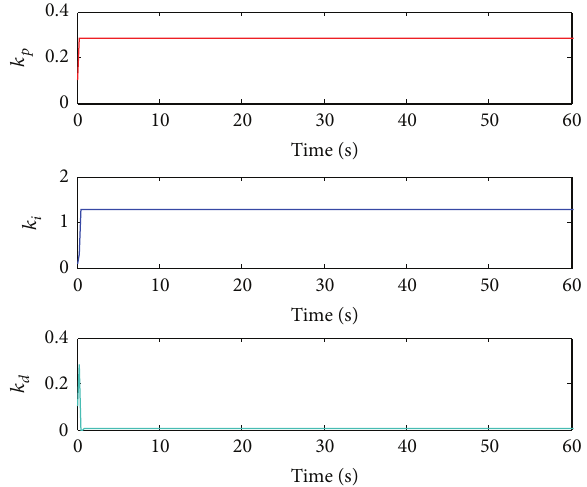
Figure 5: The adaptive tuning curve of PSO-RBF neural network PID controller.